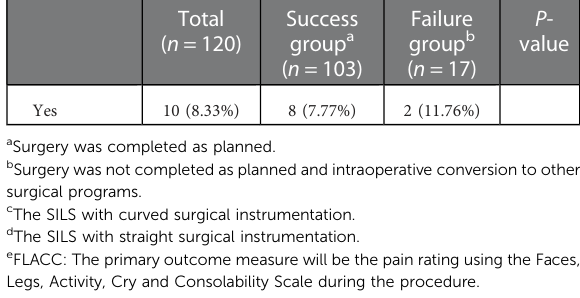
TABLE 1 The baseline and perioperative data of 120 patients undergoing SILS.